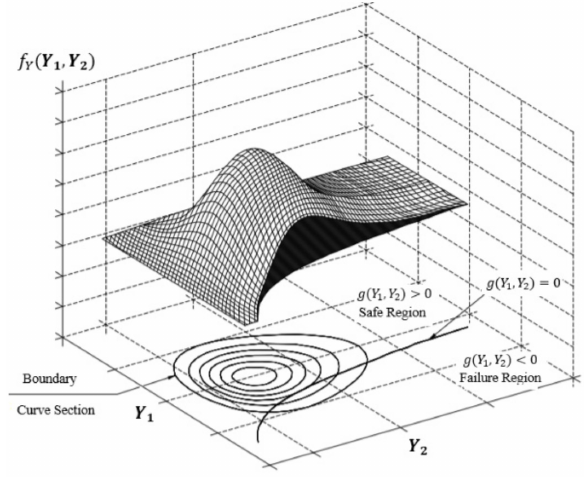
Figure 2. Probability Integration, adapted from